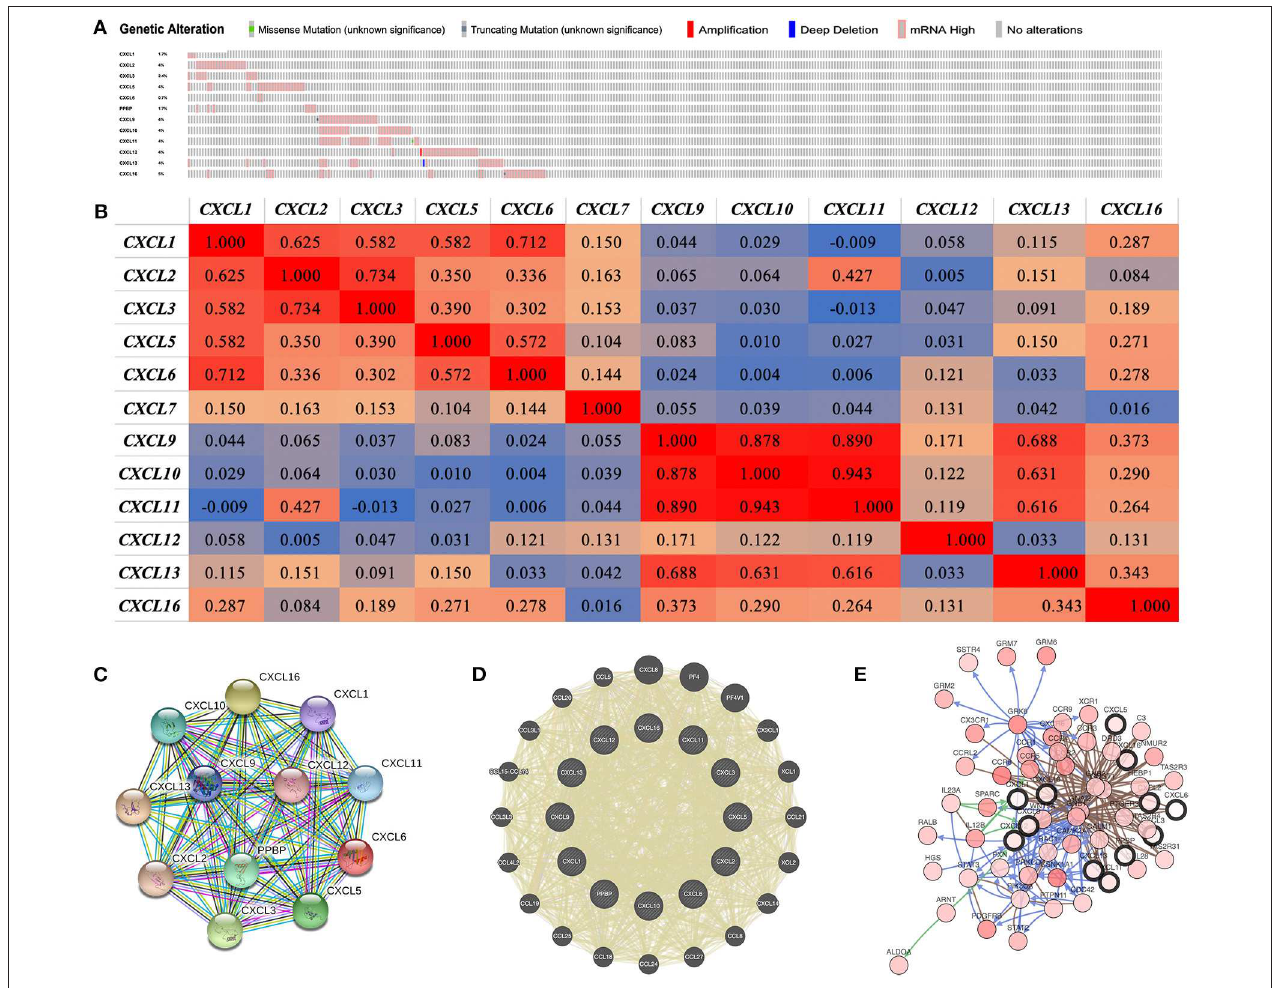
FIGURE 7 | Genetic alteration, neighbor gene network, and interaction analyses of different expressed CXC chemokines in RCC patients. (A) Summary of alterations in different expressed CXC chemokines in RCC. (B) Correlation heat map of different expressed CXC chemokines in RCC. (C,D) Protein–protein interaction network of different expressed CXC chemokines. (E) Gene–gene interaction network of different expressed CXC chemokines and 50 most frequently altered neighboring genes. the PPI network and found that biological function was mainly